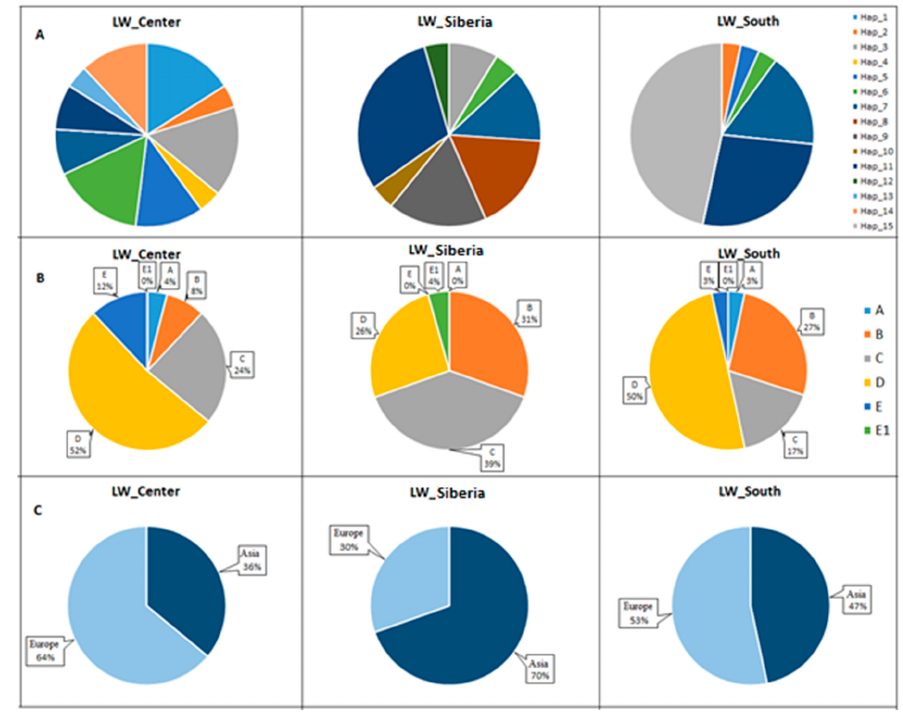
Figure 5. Frequencies of mtDNA haplotypes and haplogroups in the LW_Old group ( A —frequency distribution of haplotypes in pigs of clusters Center, Siberia and South; B —frequency distribution of haplogroups A, B, C, D, E and E1 in pigs of clusters Center, Siberia and South; C —frequency distribution of haplogroups Asia (A, B, C) and Europe (D, E, E1) in pigs of clusters Center, Siberia and South).